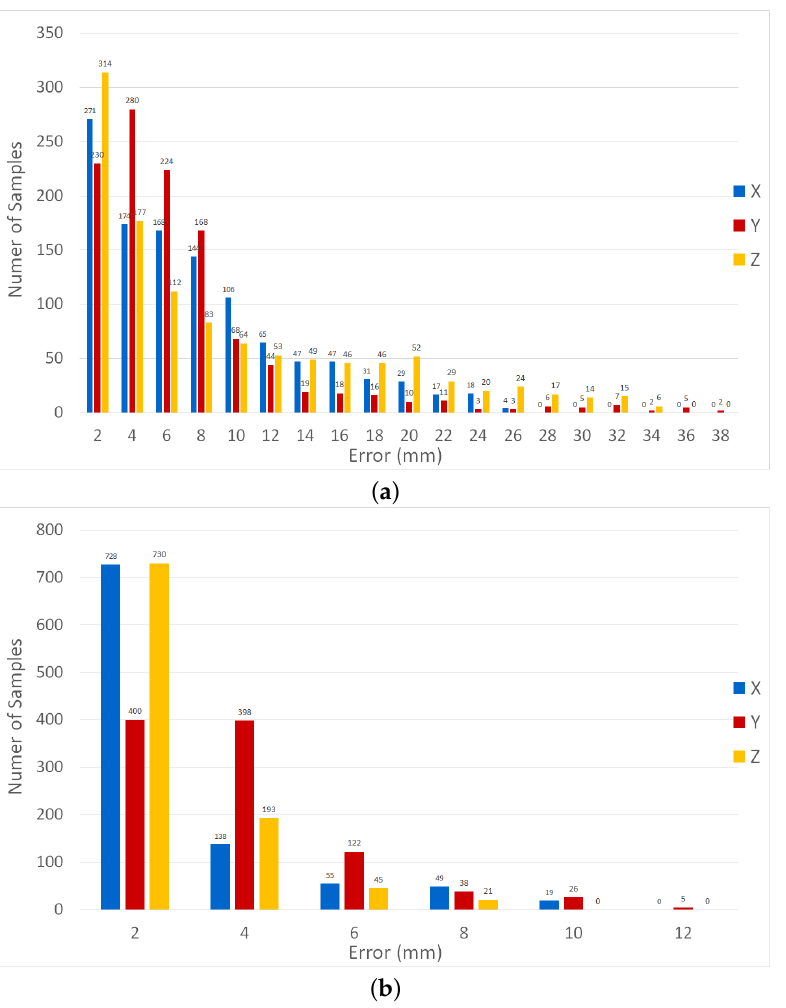
Figure 9. Histogram of the prediction errors on the FEA data. ( a ) ESN predictions. ( b ) LSTM